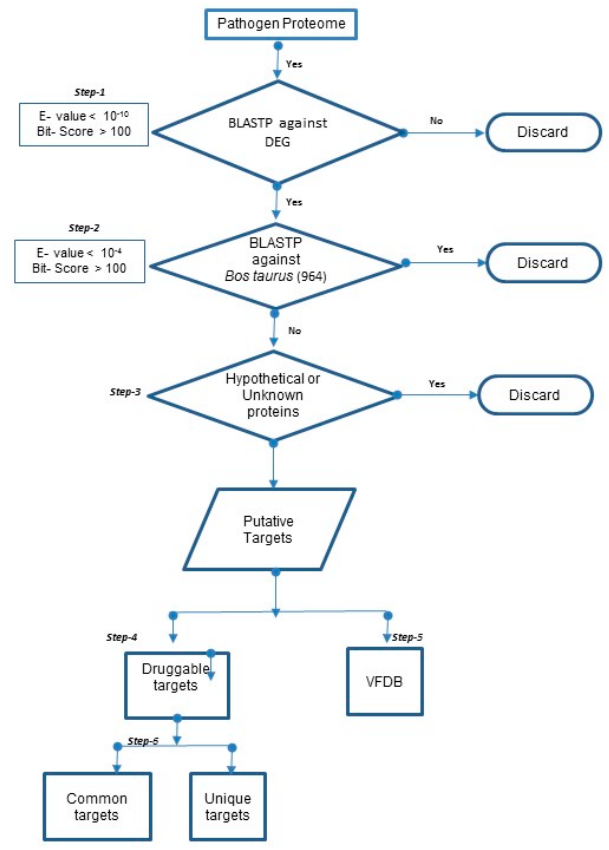
Figure 1. Flow chart for the process used for target prioritization in 20 mastitis-causing pathogens.